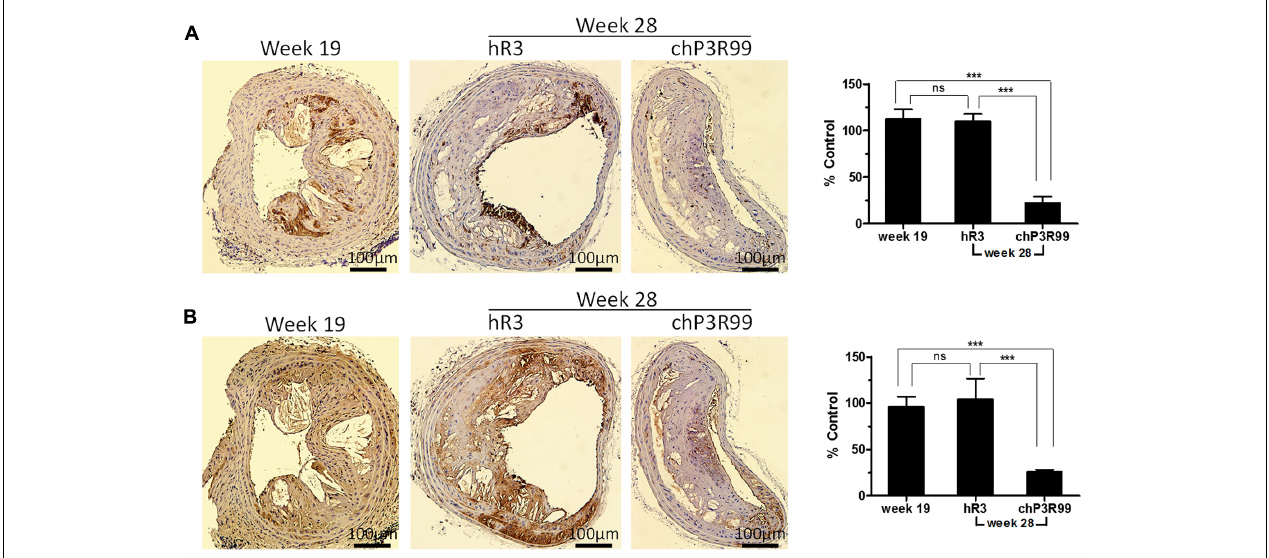
FIGURE 3 | Macrophage and T helper lymphocyte content in advanced plaques of apoE − / − mice after administration of chP3R99. Immunohistochemical staining of representative BCA artery cross-sections from 19-week-old non-treated mice and 28-week-old apoE − / − mice treated with chP3R99 or isotype-matched control hR3 were performed using primary antibodies to cell surface markers. (A) CD107b + (Mac-3 + ) macrophage staining and (B) CD4 + helper T cell staining. Bar graphs show the percentages of CD107b + − (A) and CD4 + -staining (B) relative to average staining of positive control (PBS-treated group). Data are mean ± SEM of 5 mice per group. A representative result of two independent experiments is shown. ∗∗∗ p < 0.001, one-way ANOVA followed by Tukey’s post hoc